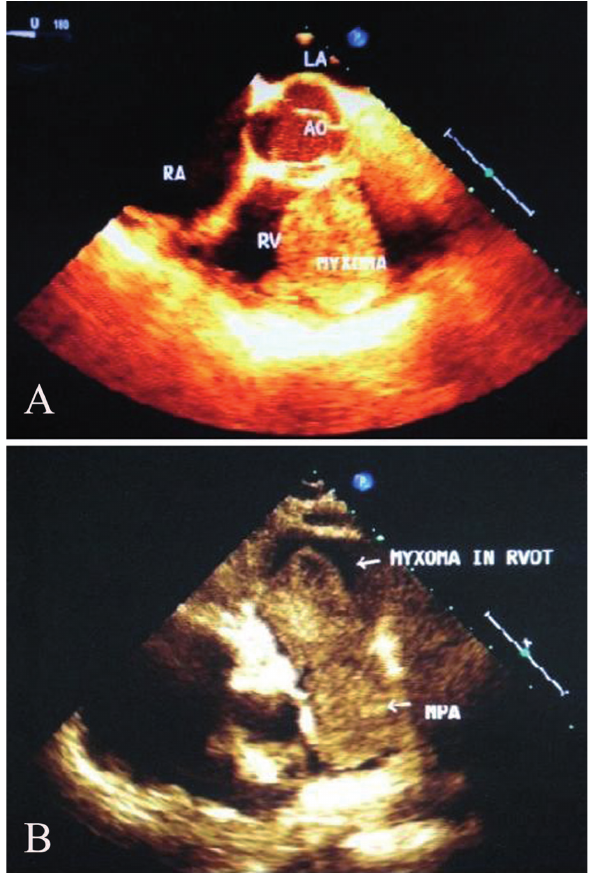
Fig. 1 – Transesophageal echocardiogram showing: A – right ventricular myxoma with its attachment to the septum; B – right ventricular myxoma prolapsing into the main pulmonary artery causing right ventricular outflow tract obstruction. LA = Left Atrium; Ao = Aorta; RA = Right Atrium; RV = Right Ventricle, MPA = Main Pulmonary Artery